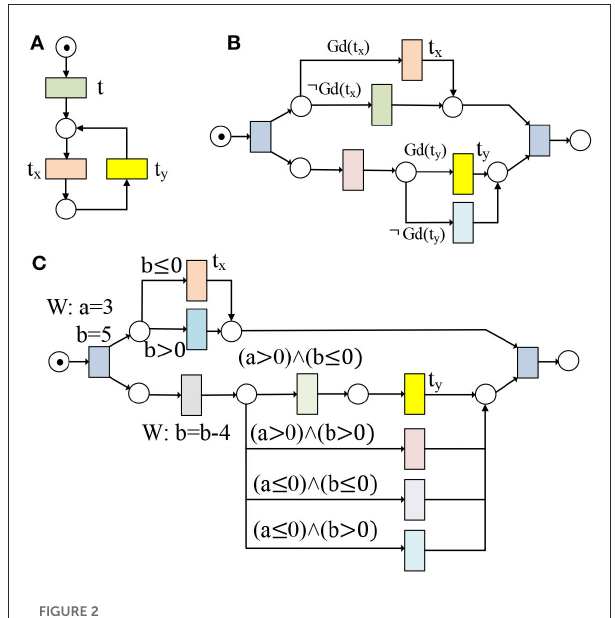
FIGURE2 (A) t x and t y are in weak circulation relation (i.e., t x ↔ c t y ); (B, C) The behavioral relation of t x and t y depends on their guard functions.